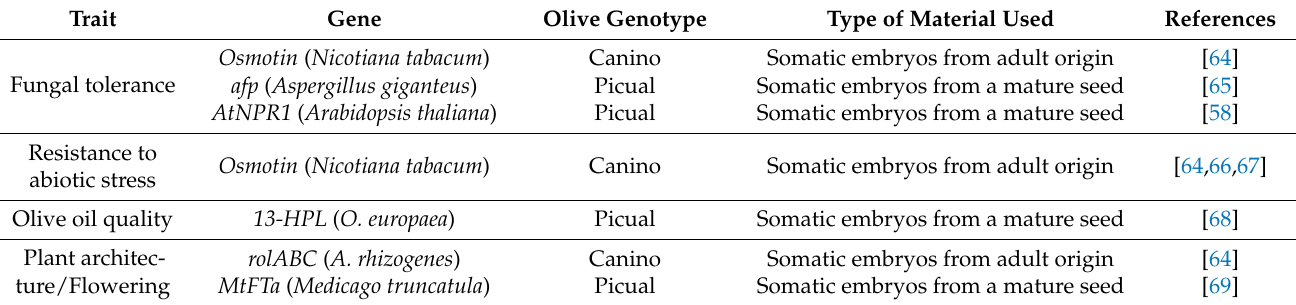
Table 1. Summary of olive transformation studies with genes of interest.